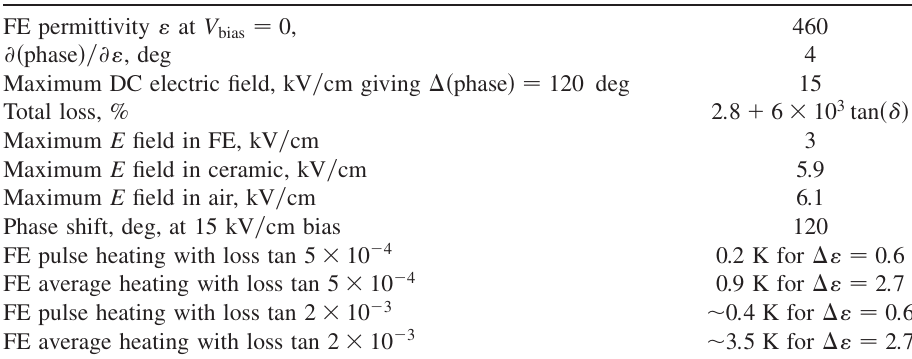
TABLE II. Design parameters of the phase